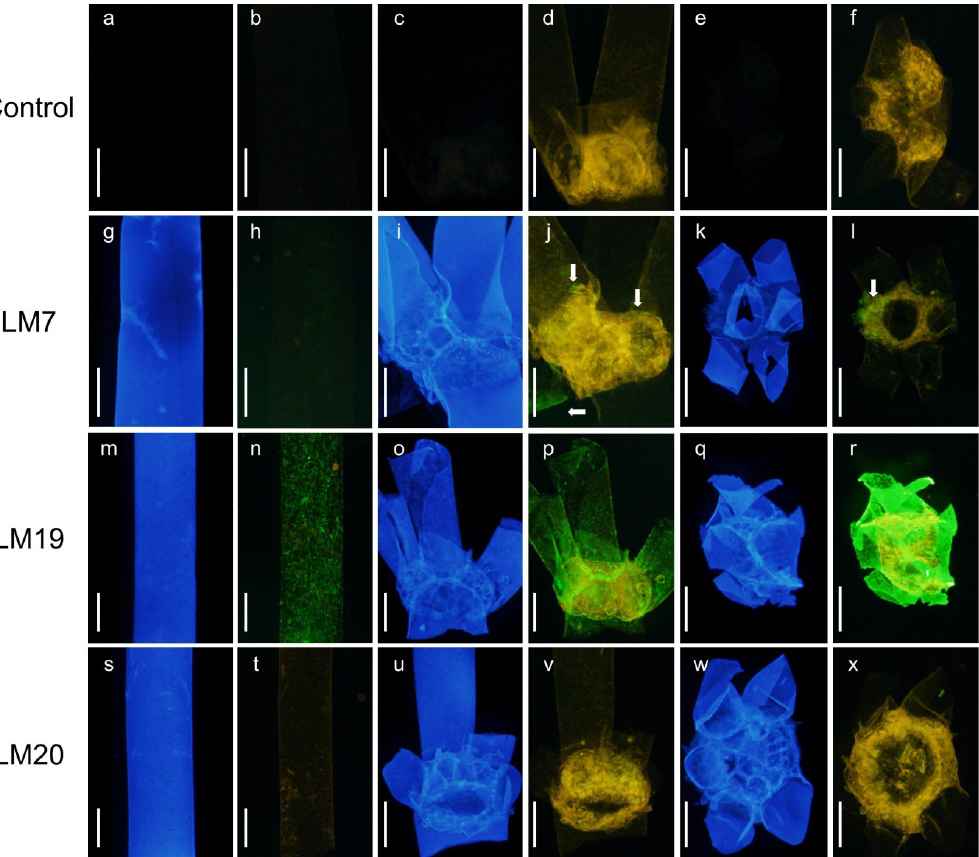
Fig. 2: Fluorescent micrographs of Chara corallina explants: internodes (a, b, g, h, m, n, s, t), longitudinal sections of nodes ( c, d, i, j, o, p, u, v) and cross sec- tions of nodes (e, f, k, l, q, r, w, x); stained with calcofluor white (g, i, k, m, o, q, s, u, w) and immunolabelled with LM7 (h, j, l), LM19 (n, p, r), LM20 (t, v, x); for control (a-f) the incubation was without calcoflour white or primary and secondary antibodies; bars = 0.5